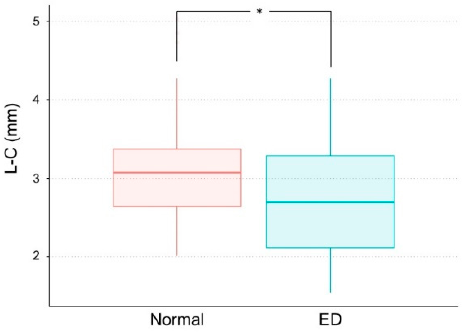
Figure 3. Box plot for comparison of the distance from the outer margin of the lingual cortex to the center of the mandibular canal (L–C) in the normal and eruption disturbance (ED) groups. Asterisk (*) indicates a significant difference.